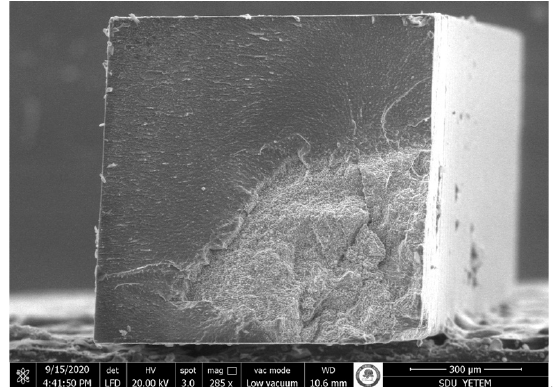
Figure 3. SEM photomicrograph of the fracture surface (aged composite side). The specimen was obtained from 6-month aging of nanohybrid composite, sandblasting, silane applied, All Bond Universal group. A mixed failure pattern was revealed. AL: Adhesive layer on the aged composite surface. RC: Fresh resin composite on the aged composite surface.